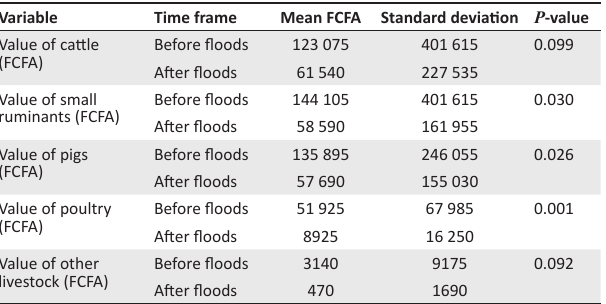
TABLE 4: Impact of floods on food